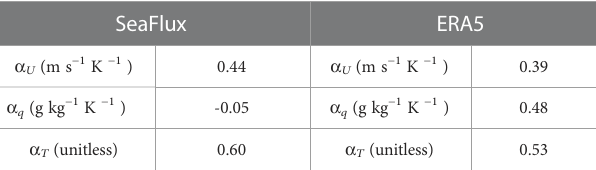
TABLE 2 Coupling coef fi cients for U10m (aU), q2m (aq), and T2m (aT) used in the downscaling algorithm for SeaFlux and ERA5.